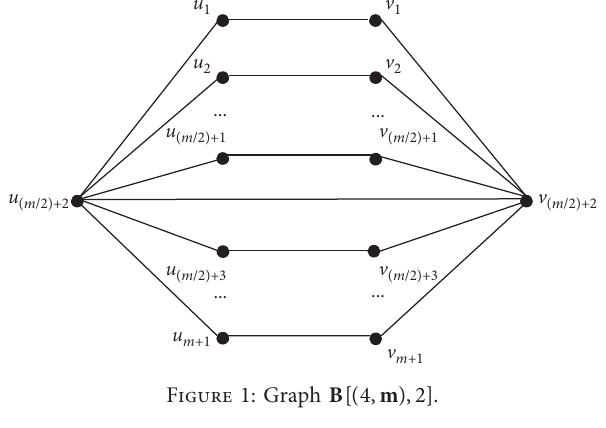
Figure 1: Graph B [( 4 , m ) , 2 ] .